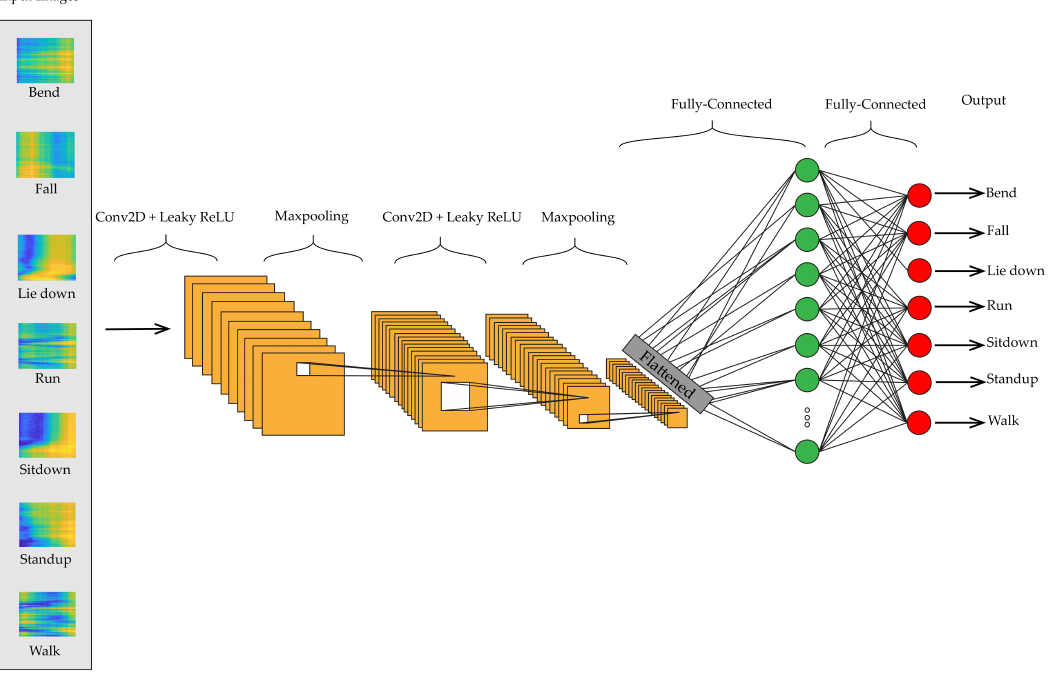
Figure 1. 2D-CNN structure used in this